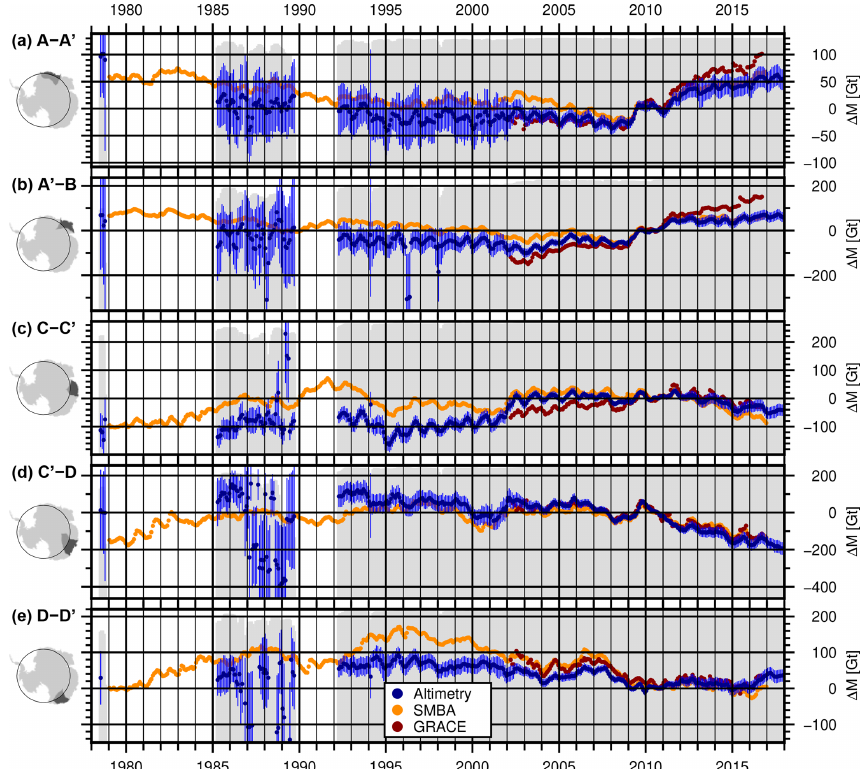
Figure 13. Mass change of subregions north of 72 ◦ S for several East Antarctic drainage basins from our combined altimetric time series (blue), GRACE (red) and SMBA (orange). The error bars show the uncertainty estimate σ (cid:54) of the altimetry data according to Sect. S6.2. The gray color in the background displays the fraction of the area covered by altimetry (the top of each panel means